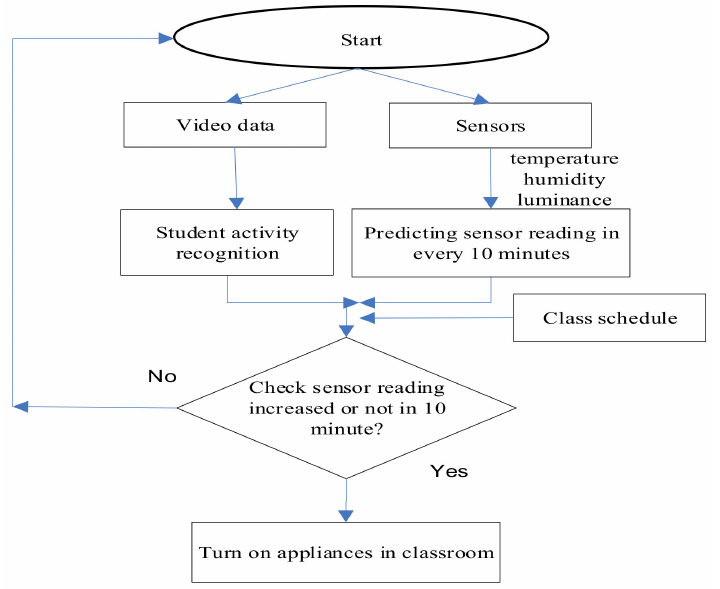
Figure 1. Proposed flow chart of our system